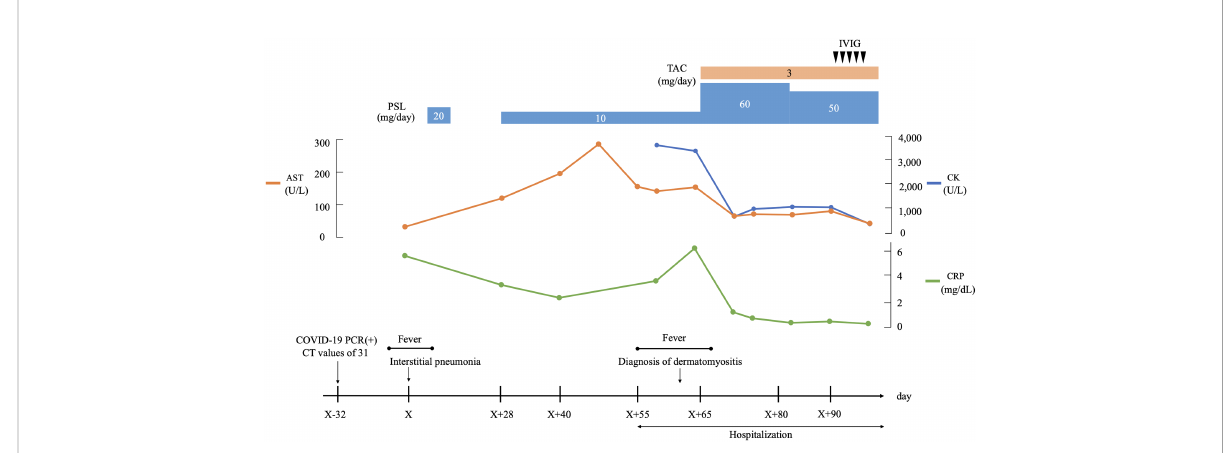
FIGURE 3 Clinical course. AST, aspartate aminotransferase; CK, creaine kinase; COVID-19, coronavirus disease 2019; CRP, C-reactive protein; CT, cycle threshold; IVIG, intravenous immunoglobulin; PCR, polymerase chain reaction; PSL, prednisolone; TAC,